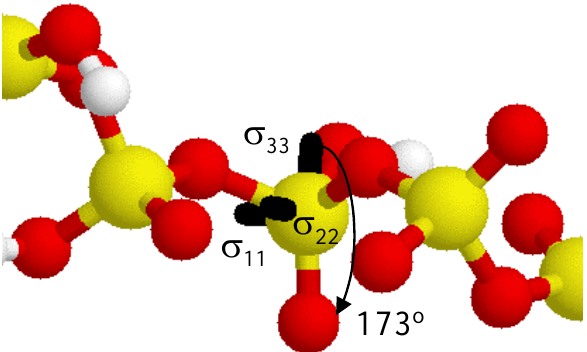
Figure 5. Relative orientation of the 31 P CSA tensor for the central phosphate in the acyclic 5-P- principal component lies ~ 173 o from the terminal P=O bond. Some membered cluster. The σ 33 intervening hydrogen atoms have been removed for